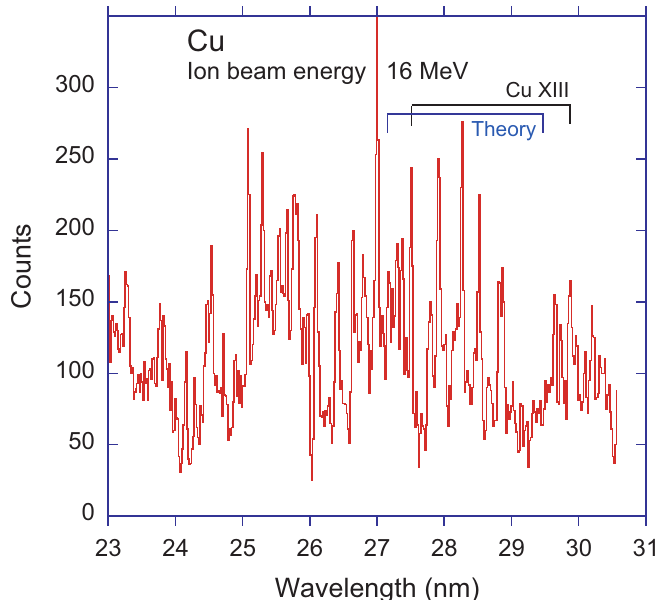
Figure 22. Beam–foil spectrum of Cu at an ion beam energy of 16 MeV. Line width (FWHM) 0.045 nm, observation near the foil. The charge state distribution maximum is near q = 12 + , and ion charge states q = 9 + to q = 15 + are expected to contribute. The marked Cu XIII line pair is discussed in the text. Black marker: experiment [50], blue marker: theory